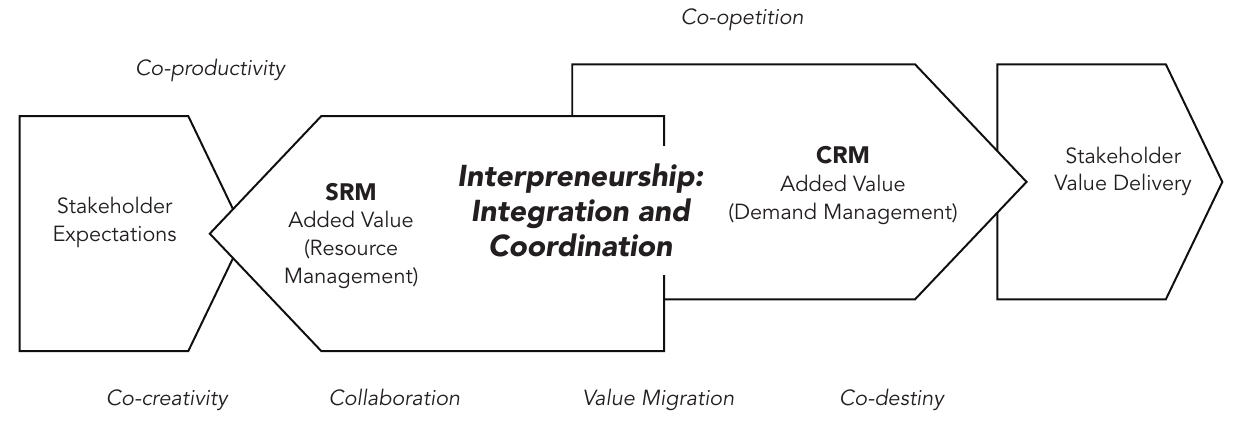
Figure 1: A value chain network-based business